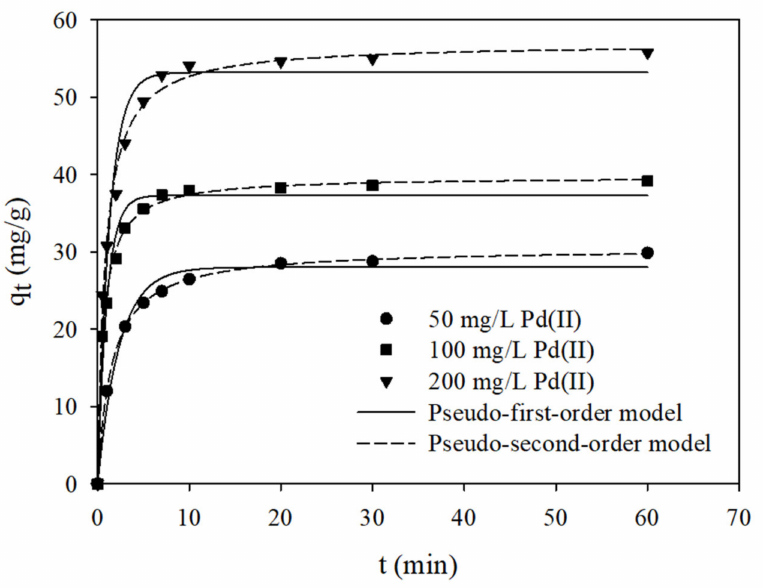
Figure 4. Pseudo-first-order and pseudo-second-order fitting of the adsorption kinetics of Pd(II) by PEI-chitin at the initial Pd(II) concentrations of 50, 100, and 200 mg/L.